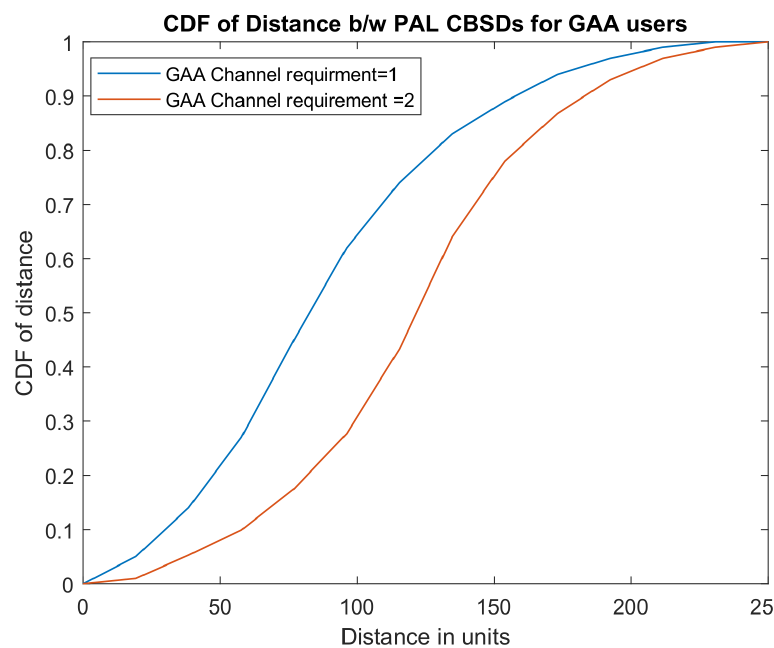
Figure 3. CDF of InterCBSD distance.